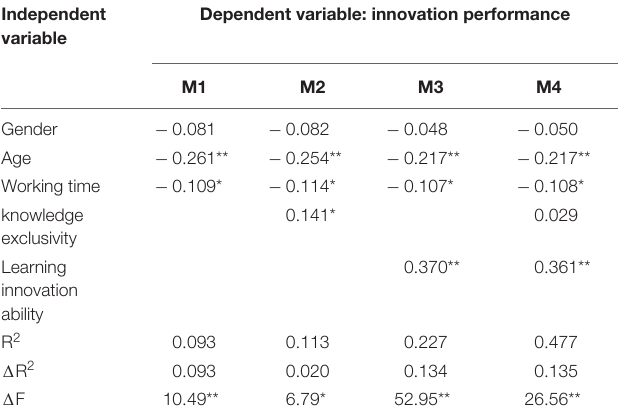
TABLE 2 | Regression analysis of alliance member ability on innovation performance.